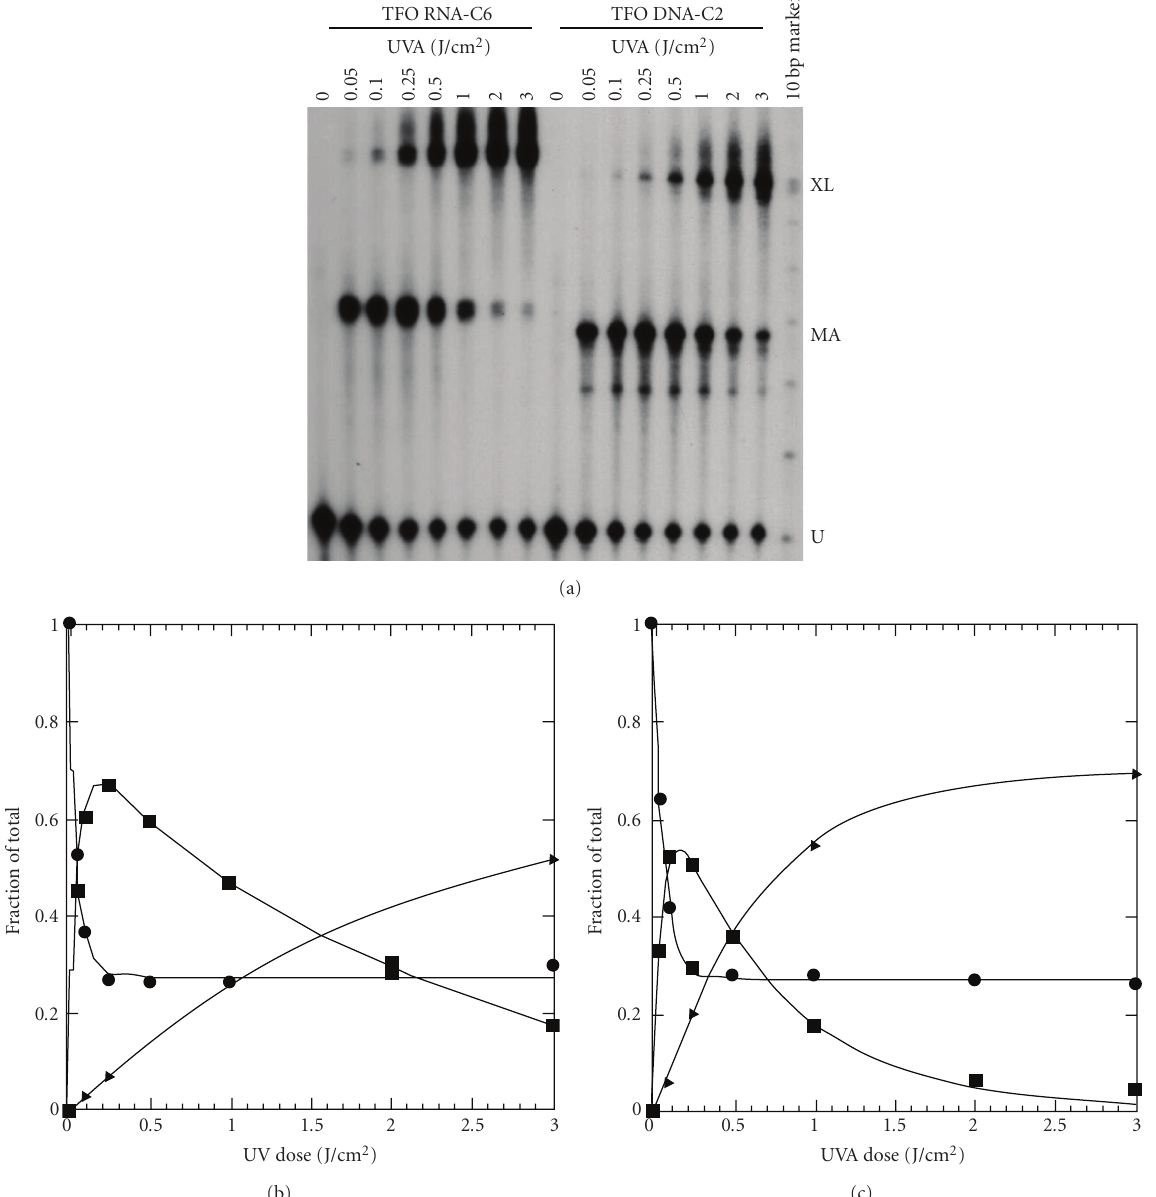
Figure 5: Photoreactivity of TFOs conjugated to HMT. 50nM TFO DNA-C2 or TFO RNA-C6 were incubated with 5nM duplex target overnight and then irradiated with varying doses of UVA. (a) Separation of reaction products by polyacrylamide gel electrophoresis under denaturing conditions. The products are marked as unreacted (U), monoadducts (MA), and crosslinks (XL). Quantitative analysis (b) TFO DNA-C2 and (c) TFO RNA-C6 for unreacted DNA (circles), MA (squares), and XL